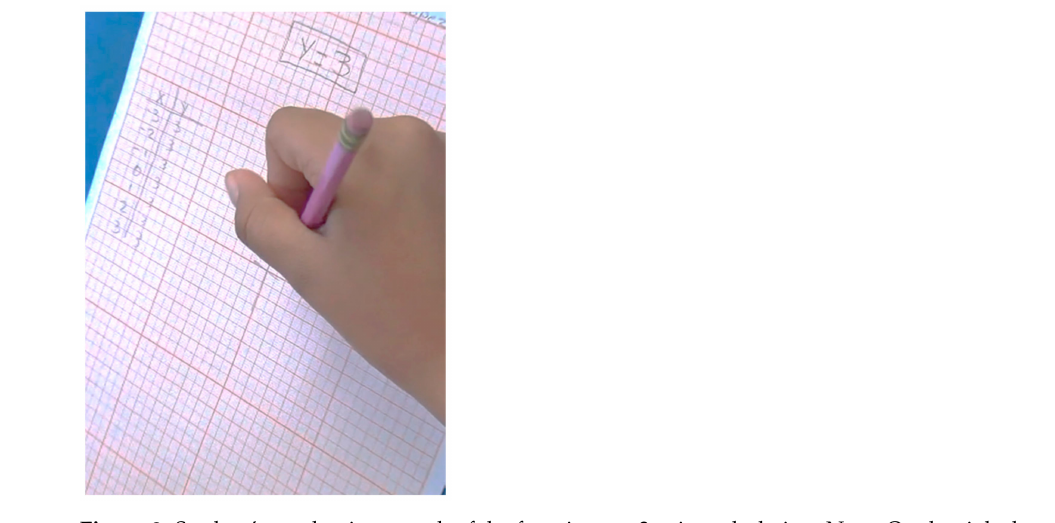
Figure 3. Student’s production: graph of the function y = 3 using tabulation. Note: On the right-hand side of the image, the reader can see a table in which values are assigned for the independent variable and the value of 3 is replicated in the dependent